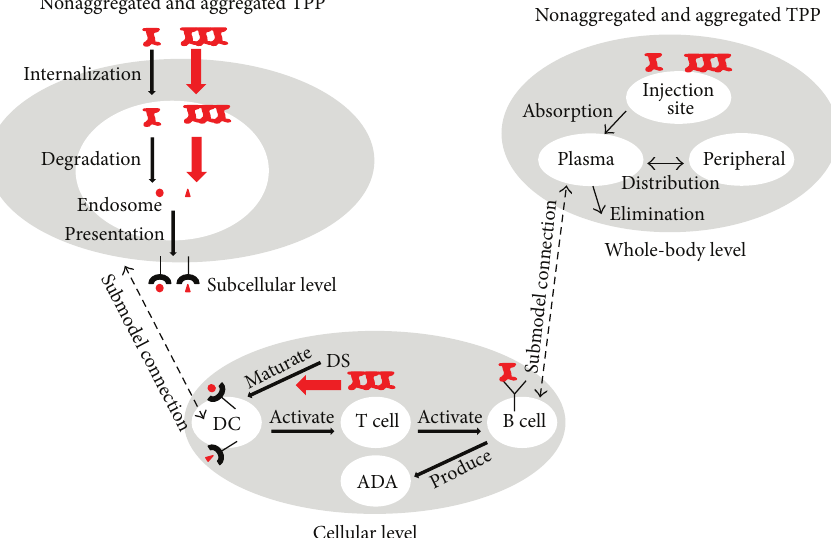
Figure 3: Schematic highlighting of the potential role of aggregates in T cell-dependent ADA production. A recapitulation of our system-level model for T cell-dependent ADA production [47, 48]. At the subcellular level, TPP are internalized into endosome of APC, such as dendritic cells (DC), and then degraded into antigenic peptides. Epitopes derived from TPP could be loaded onto MHC II and presented on the surface of APC. Aggregates could contribute to enhanced ADA production by having increased internalization or degradation rate or number and affinity of epitopes generated (indicated by thick red arrows). At the cellular level, danger signal (DS) maturated DC activate T cells which in turn activate B cells to generate ADA. Aggregates could enhance the DS to maturate DC (see red arrow). At the whole-body level, aggregated and nonaggregated TPP are absorbed from the injection site into plasma and will be distributed into periphery, eliminated, or captured by B cells through BCR